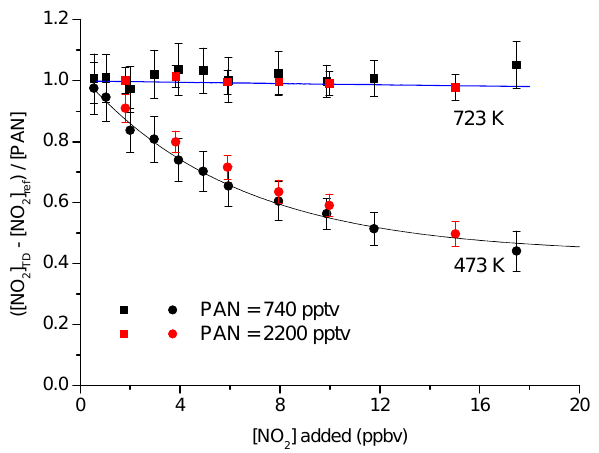
Figure 9. Measurements of the difference signal (TD cavity sam- pling from the 473 (squares) or 723K inlet (circles) – NO 2 refer- ence cavity) when adding different amounts of NO 2 to PAN sam- ples (740 or 2200pptv). [NO 2 ] TD refers to the mixing ratio of NO 2 measured in the TD cavity sampling from either the 473 or 723K inlet. The blue line denotes the model prediction of the effect of adding NO 2 to the 723K inlet. The black line shows an exponential fit to the NO 2 measured when sampling from the 473K inlet and is added to guide the eye. The error bars represent standard deviation and were derived by propagating errors in the NO 2 signals in the TD and reference cavities.